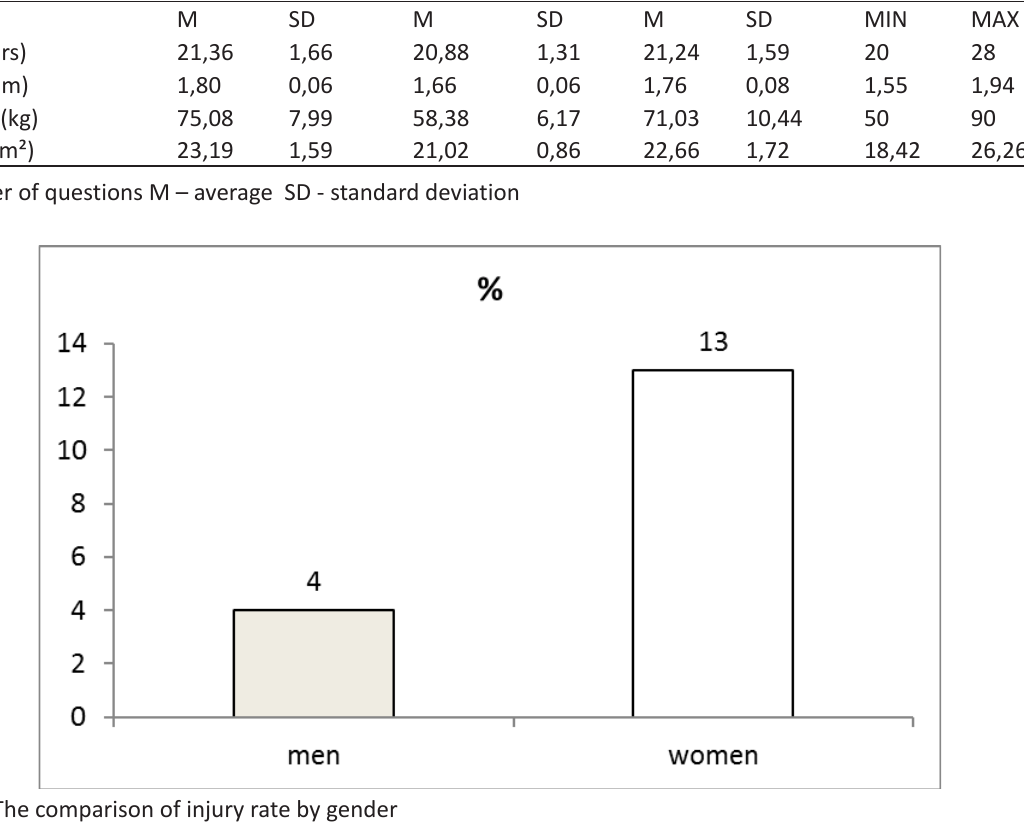
Table 1. The anthropometric characteristics of the skiers in Poland (students) SKIERS